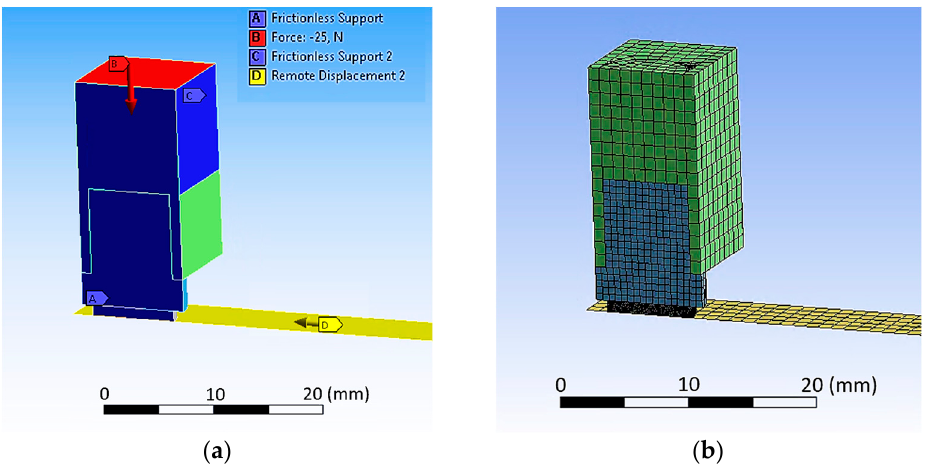
Figure 6. Full 3D model of the test setup including the sample holder and the adapter with ( a ) applied boundary conditions and ( b ) numerical mesh with 39,526 elements.